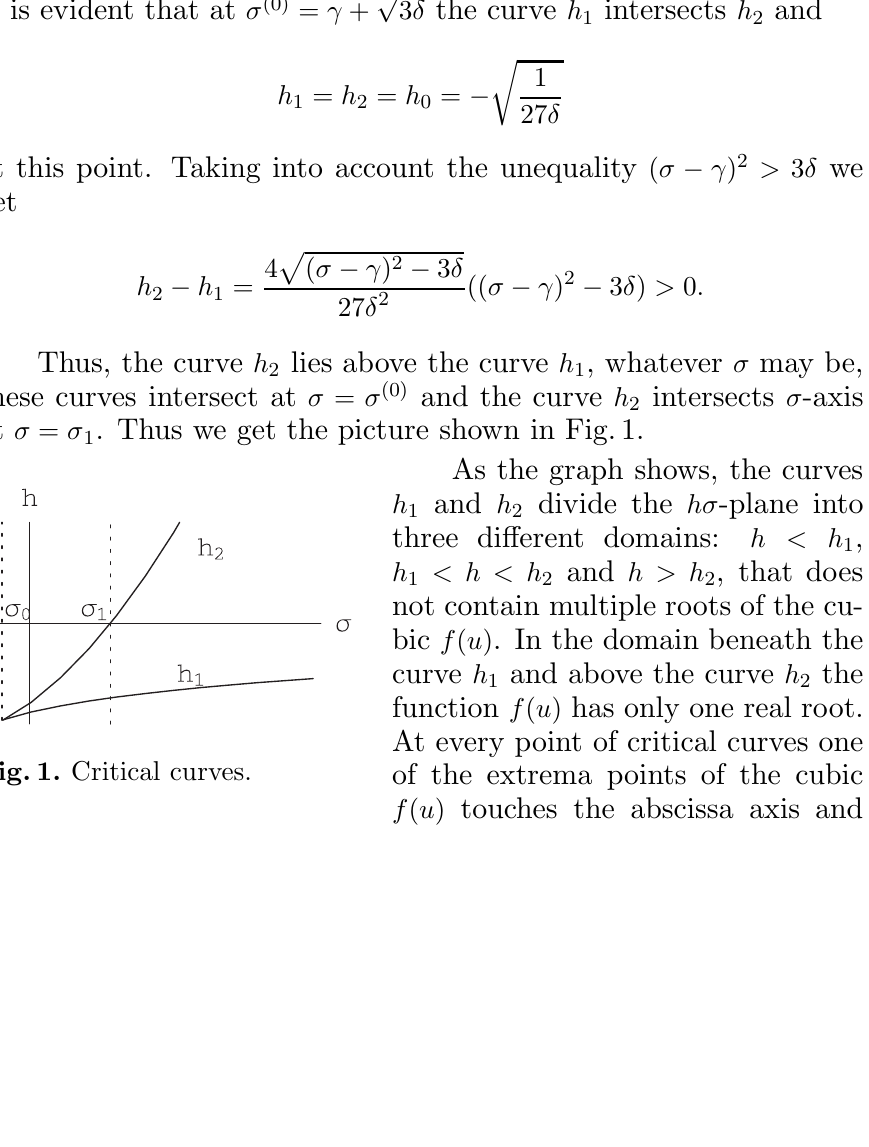
Fig. 1. Critical curves.